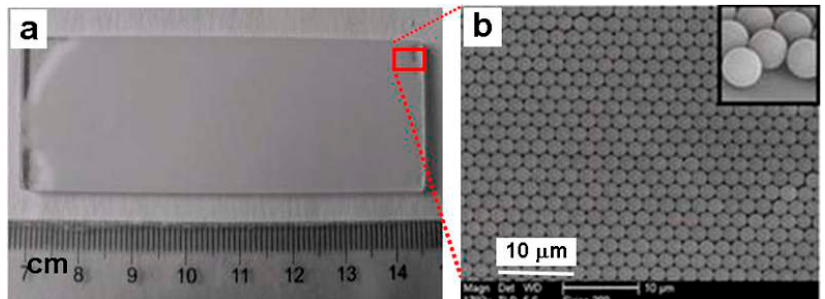
Figure 1. The PS colloidal monolayer with 2 μ m in the PS sphere’s diameter on the glass. ( a ): A photograph of the colloidal monolayer on the glass slide. ( b ): The scanning electron microscopic (SEM) image corresponding to the area of the rectangular frame marked in (a). The inset is a locally magnified image in the edge region of the slide, showing the monolayer.